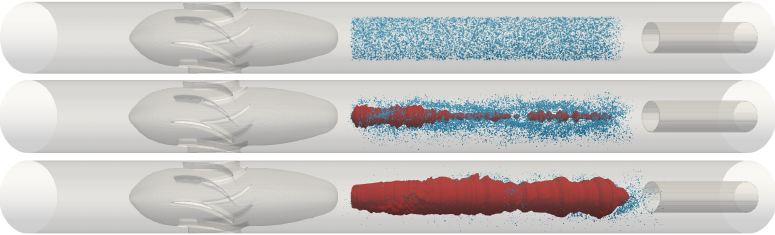
Figure 20. Simulation performed using the hybrid Lagrangian tracking–volume of fluid solver. The blue dots correspond to bubbles, and the red region corresponds to the coalesced core. ( Top ) t = 0 s (initial condition); ( Middle ) t = 0.011 s; ( Bottom ) t = 0.040